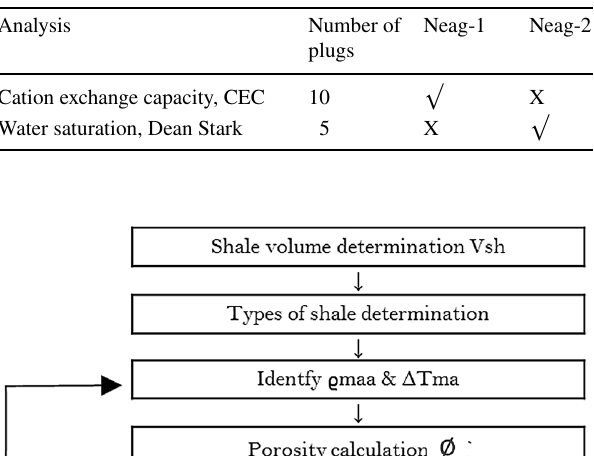
Table 2 Summary of available core analysis data